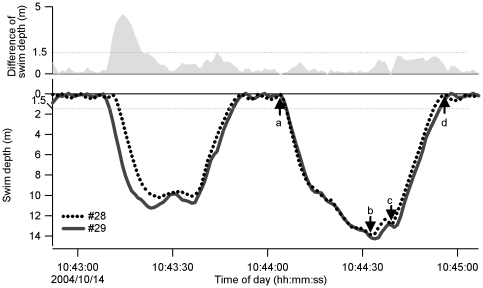
An example of synchronous diving in 2 finless porpoises.The first dive was not considered a synchronous dive (SD), whereas the second was considered SD. The initiator and follower were determined at 4 points: starting a dive (a), reaching a maximum depth (b), starting an ascent (c), and ending the dive (d).